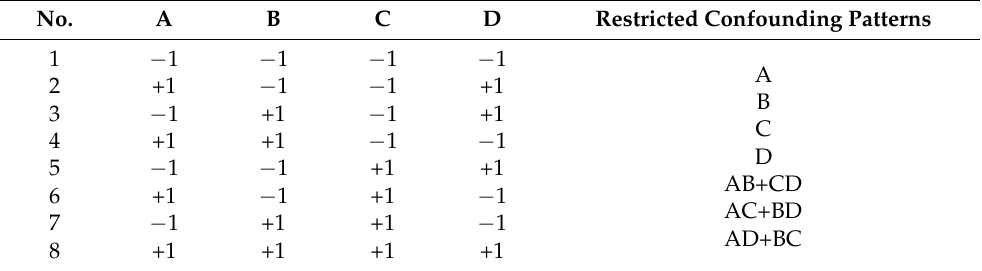
Table 3. Matrix of